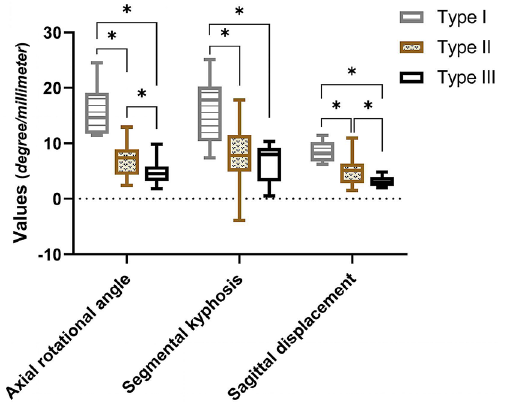
Figure 3. Box and whisker plots showing the instability parameters of the injured segment in each type of UCLF. Statistical significances were determined by One-way ANOVA analysis of variances between the groups, * indicates a significant difference between the types based on Duncan’s multiple comparison tests.